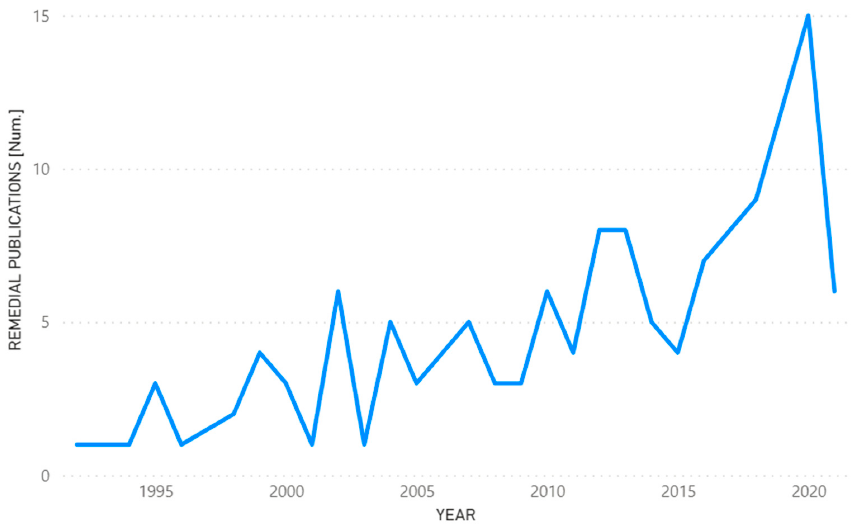
Figure 9. Contribution of scientific remedial publications by years.